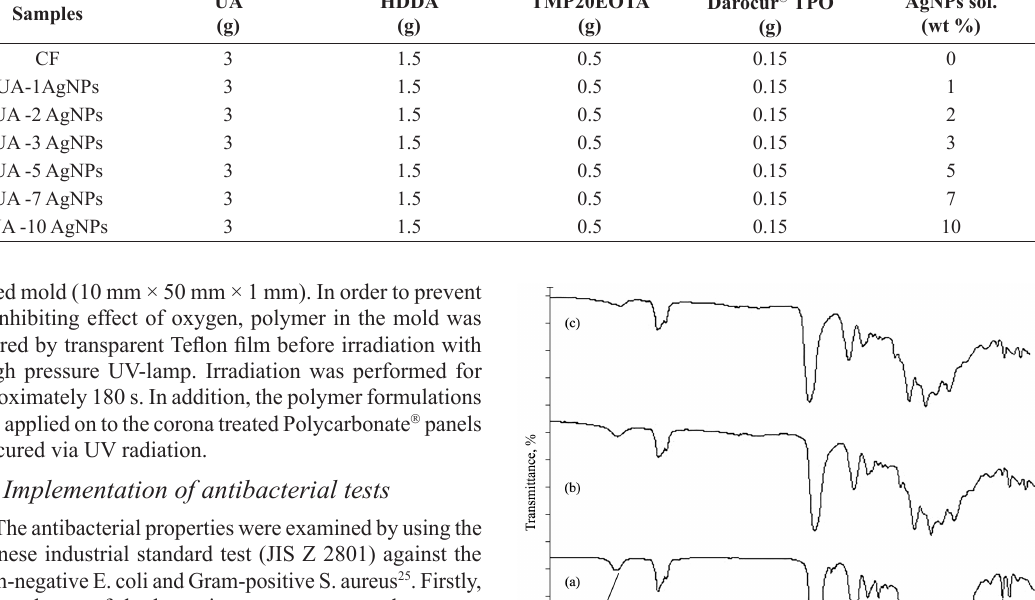
Table 1. Composition of the formulations. Samples